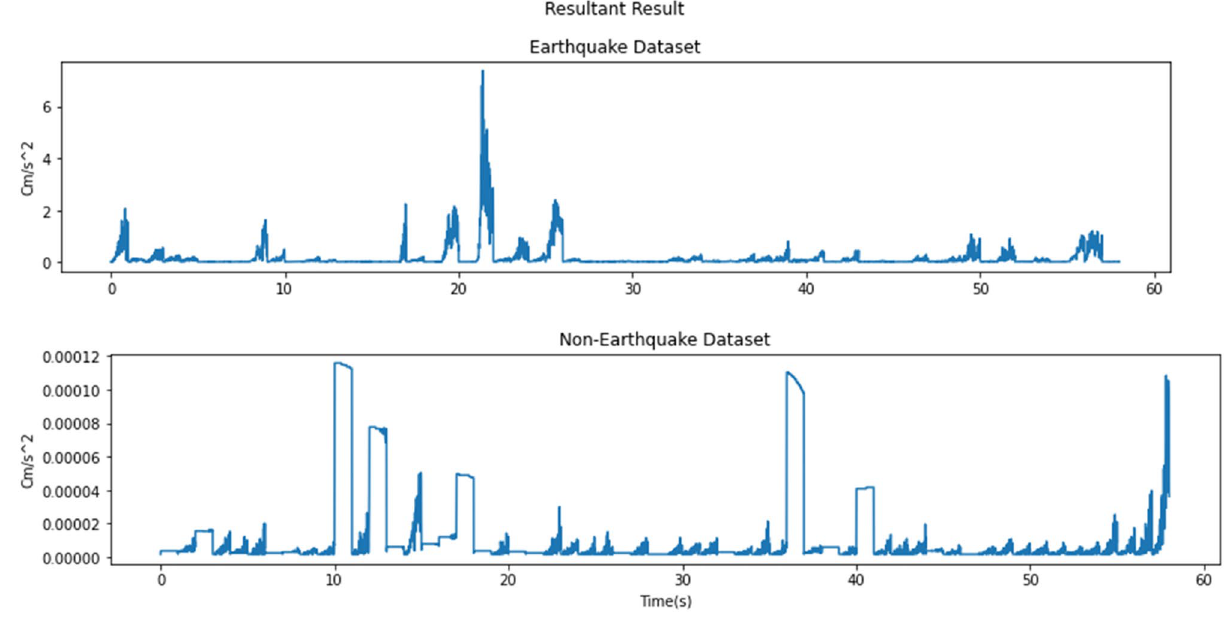
Figure 5. Resultant result.